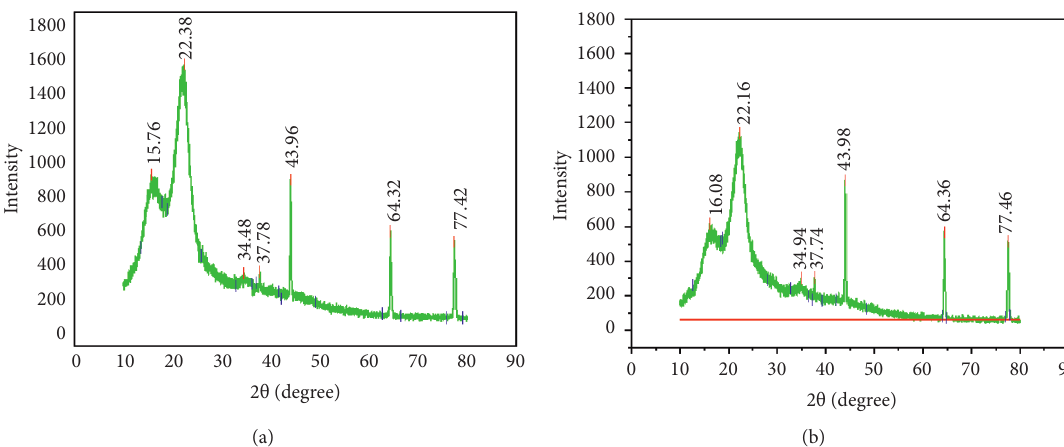
Figure 2: XRD analysis of raw (a) and acid hydrolyzed (b) Teff straw.